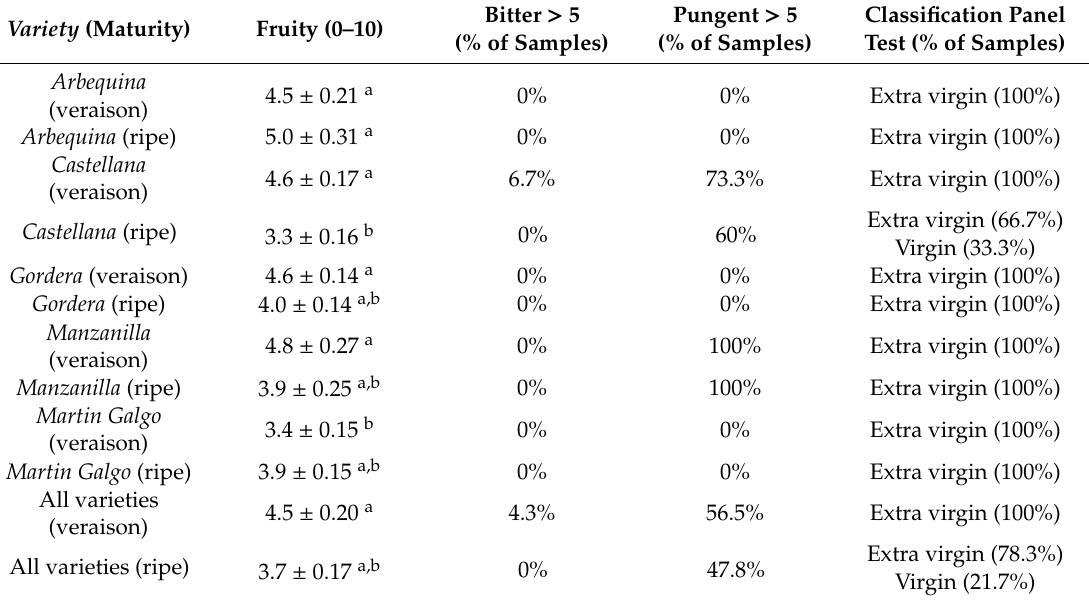
Table 2. Results obtained for the positive sensory attributes evaluated and the Panel Test classification of the samples of virgin olive oil analyzed, from the di ff erent olive varieties grown in the study area, collected at di ff erent stages of